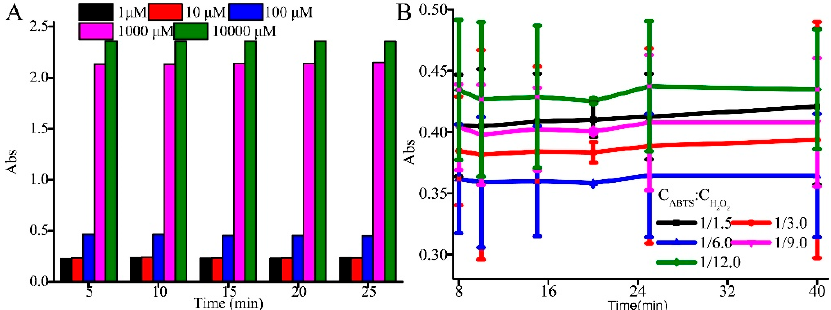
Figure 3. Optimization of the catalytic system ( A ) hemin and ( B ) ABTS-H 2 O 2 .